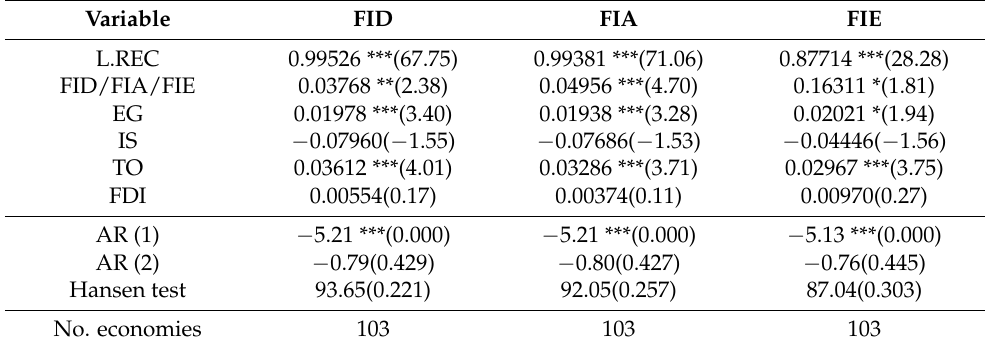
Table 9. Regression results of third level of financial development (FID, FIA, and FIE).